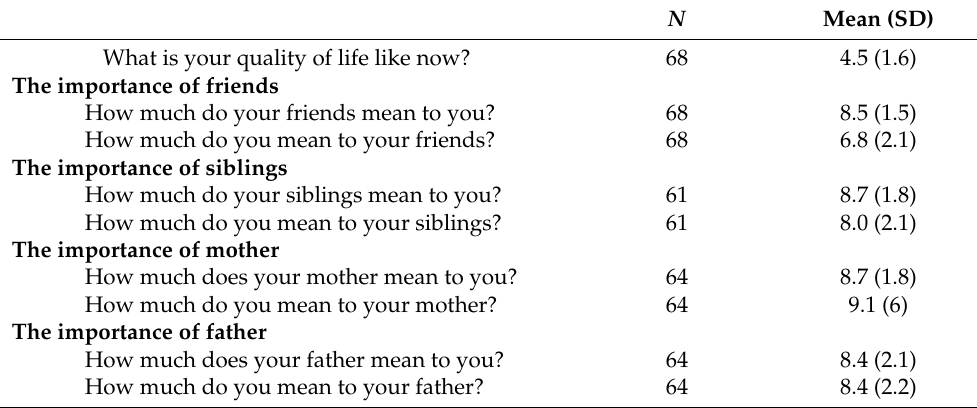
Table 4. Adolescent Relationships Scale (ARS) mean scores and standard deviations in the First Experimental Study of Transference Interference-In Teenagers